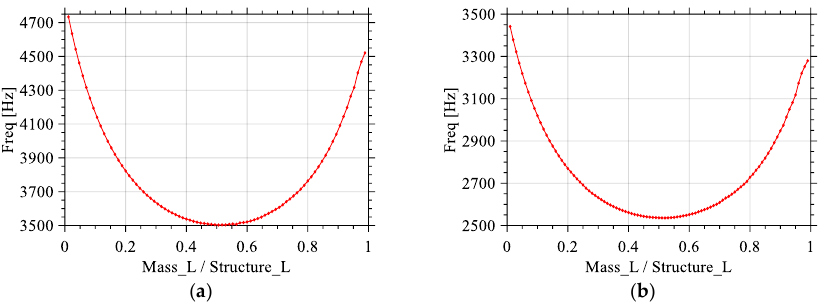
Figure 5. Effects of the variation of ratio of the mass length (Mass_L) to the total structure length (Structure_L) on the value of the first Eigen frequency for structure length of ( a ) 1700 µ m and ( b ) 2000 µ